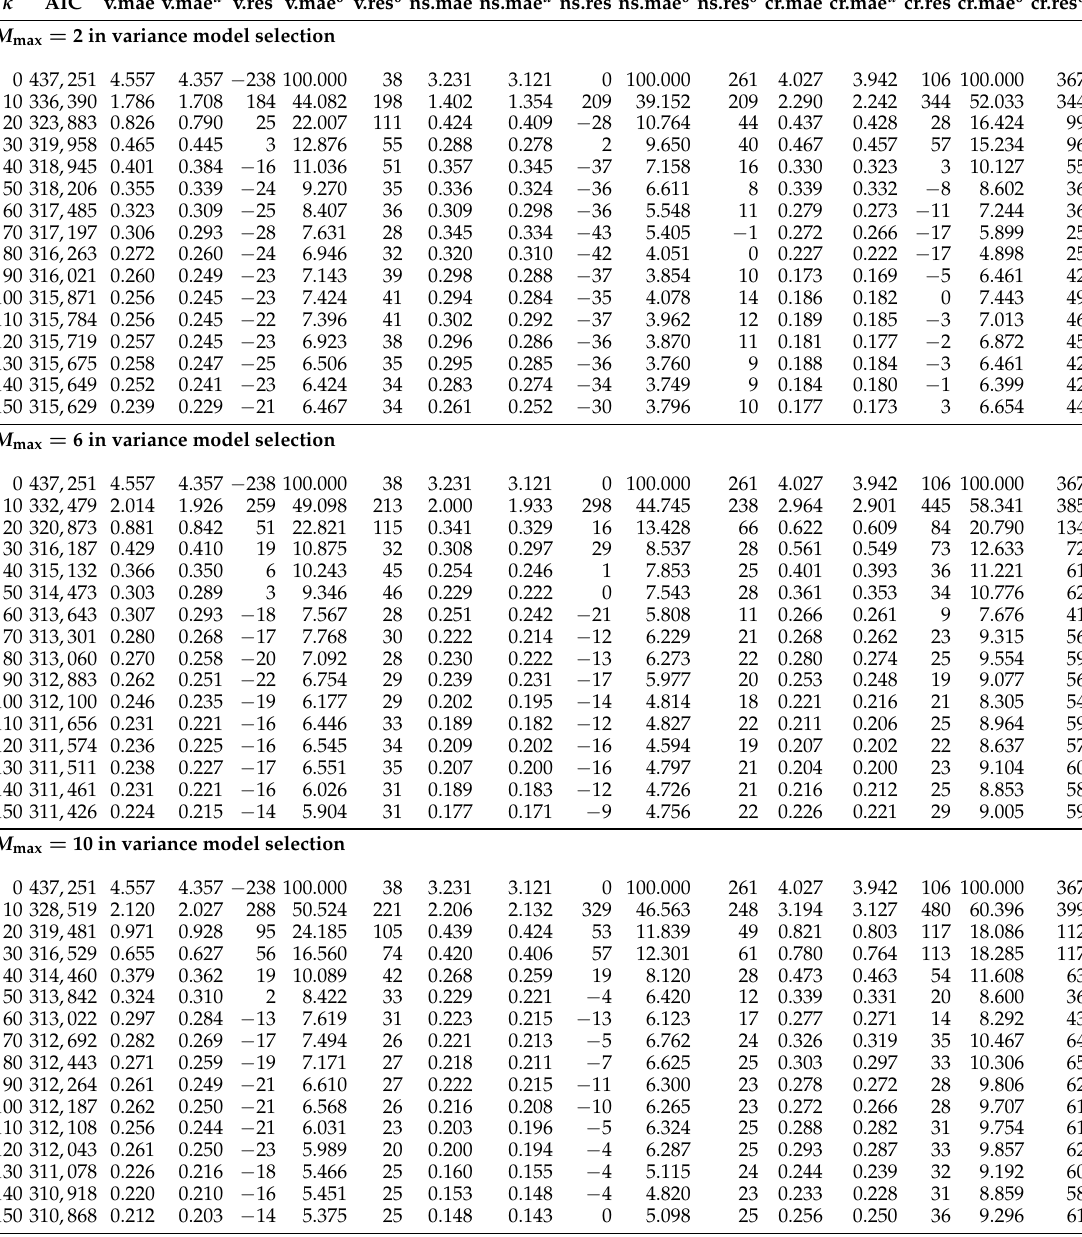
Table A28. AIC scores and out-of-sample validation figures of type II FGLS proxy functions of BEL under 150–443 with variance models of varying complexity M max after each tenth